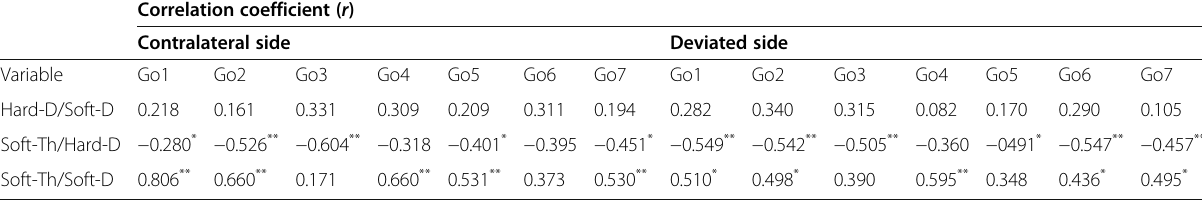
Table 4 Correlation between hard and soft tissue changes Correlation coefficient ( r ) Contralateral side Deviated side Variable Go1 Go2 Go3 Go4 Go5 Go6 Go7 Go1 Go2 Go3 Go7 Hard-D/Soft-D